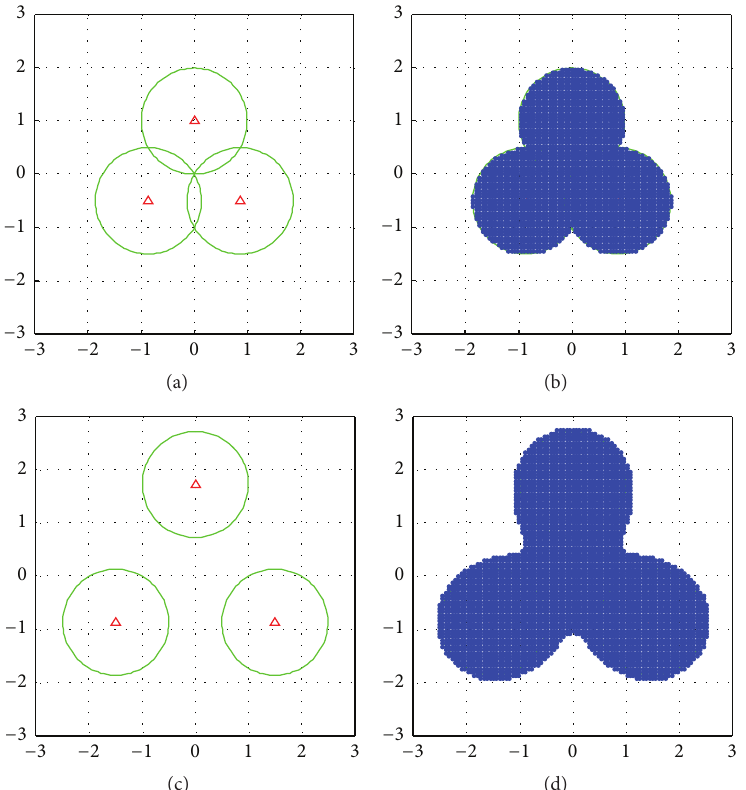
Figure 2: (a) Deployment for physical coverage. (b) Case of physical coverage. (c) Deployment for (3,𝜀) information coverage. (d) Case of (3,𝜀) information